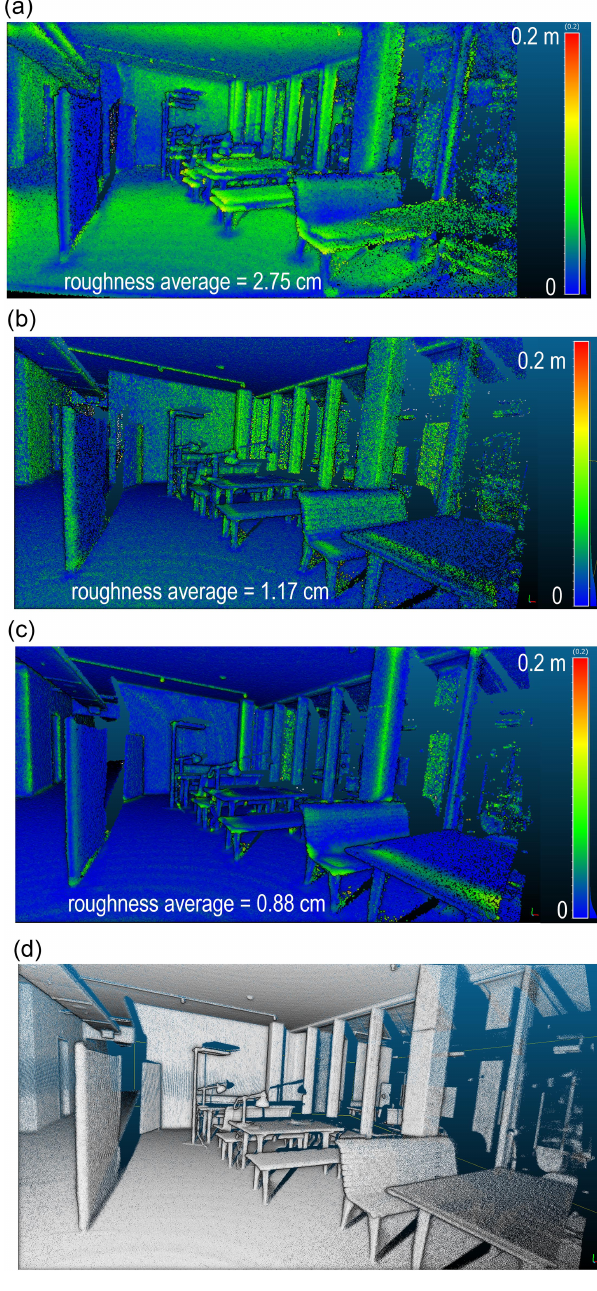
Figure 5. Point cloud roughness for adjustment steps: (a) scan with- out adjustments; (b) scan after adjustments of α 1 and α 2 ; (c) final scan; (d) final scan (EDL